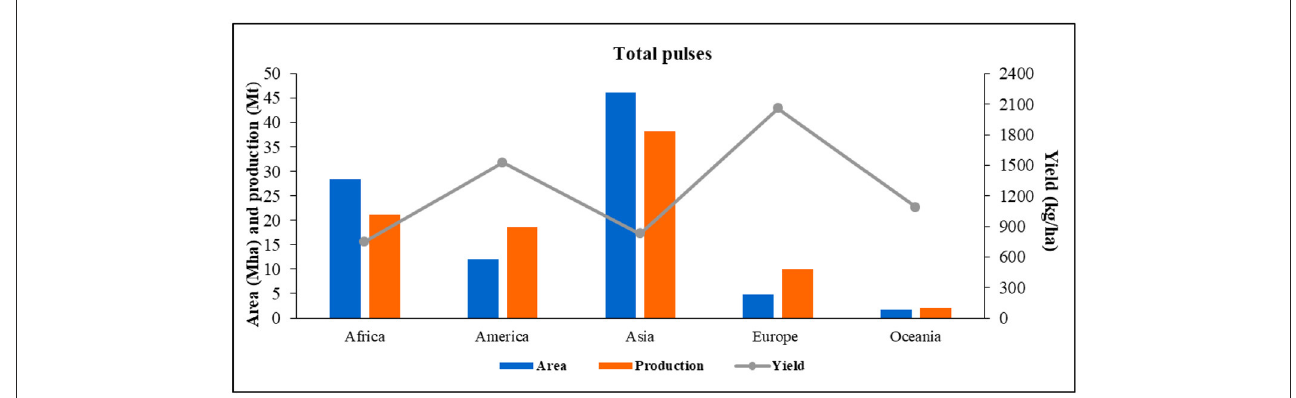
FIGURE1 Area, production, and yield of total pulses in different regions of the world in 2020 (Data Sources: FAOSTAT, 2022).